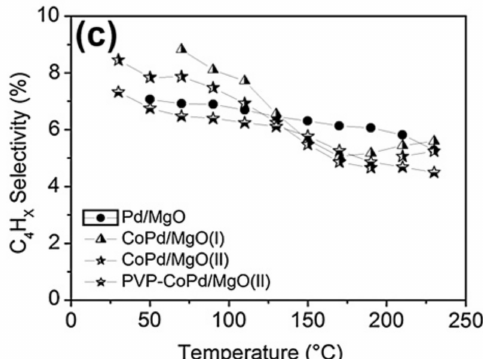
Figure 18. Acetylene conversion ( a ), ethylene selectivity ( b ), and C4 selectivity ( c ) as functions of temperature. Acetylene conversion is given by the difference of the inlet and outlet concentrations in vol %. Ethane formation is given by vol% of ethane in the reactor off-gas. (Conditions: 0.5 vol % C 2 H 2 , 1 vol % H 2 , and 70 vol % C 2 H 4 in N 2 , flow velocity 50 mL/min.) (reproduced with permission from [277]. Copyright 2013, Elsevier Inc.).